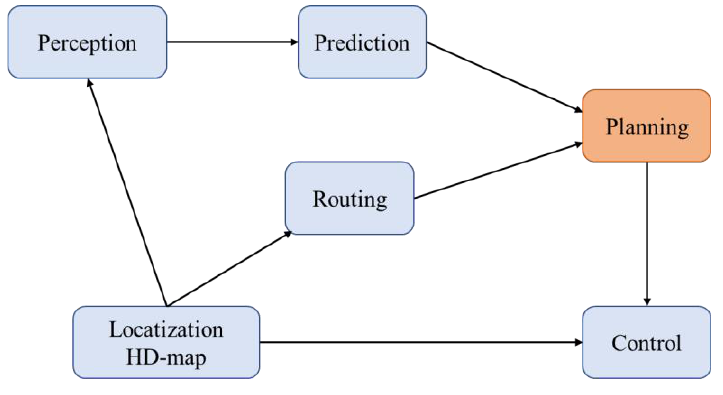
Figure 1. Autopilot system flow chart.